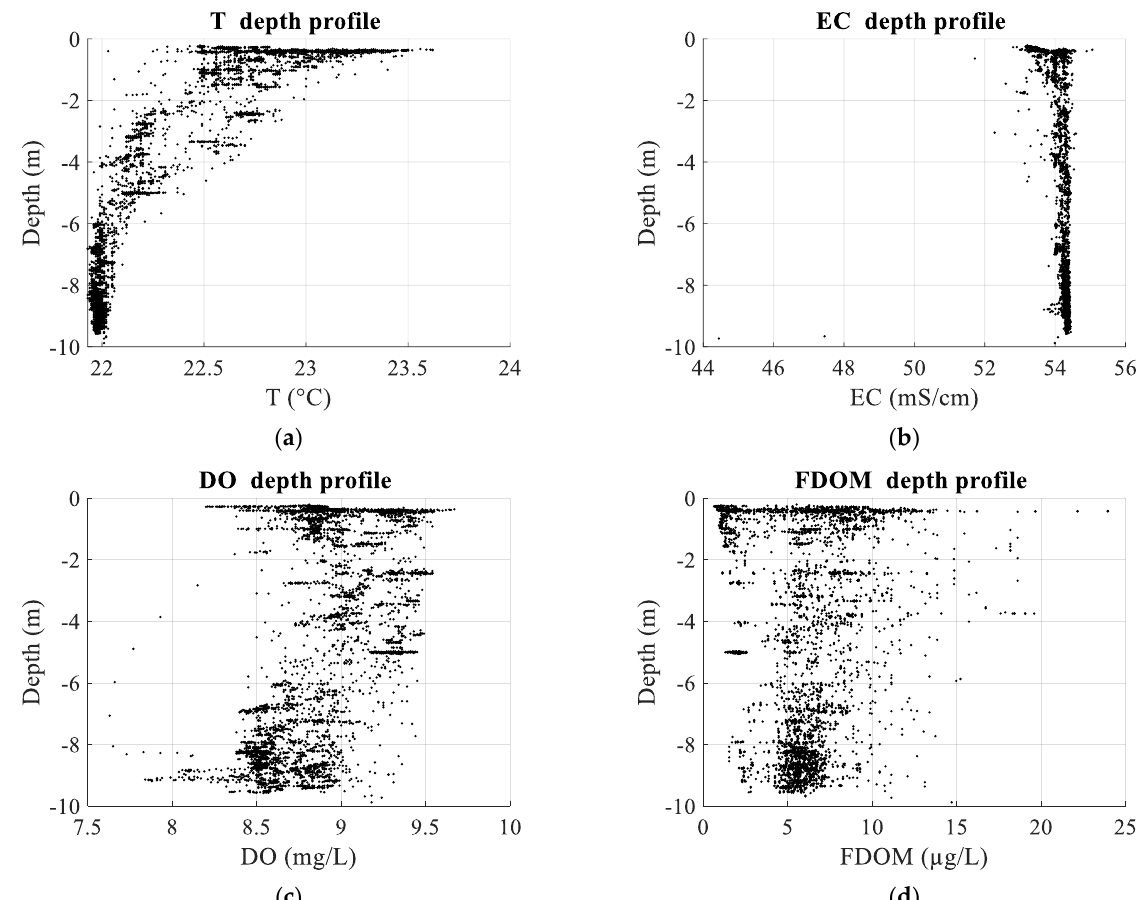
Figure 13. Depth profiles for ( a ) temperature, ( b ) electric conductivity, ( c ) dissolved oxygen, and ( d ) dissolved organic matter fluorescence.